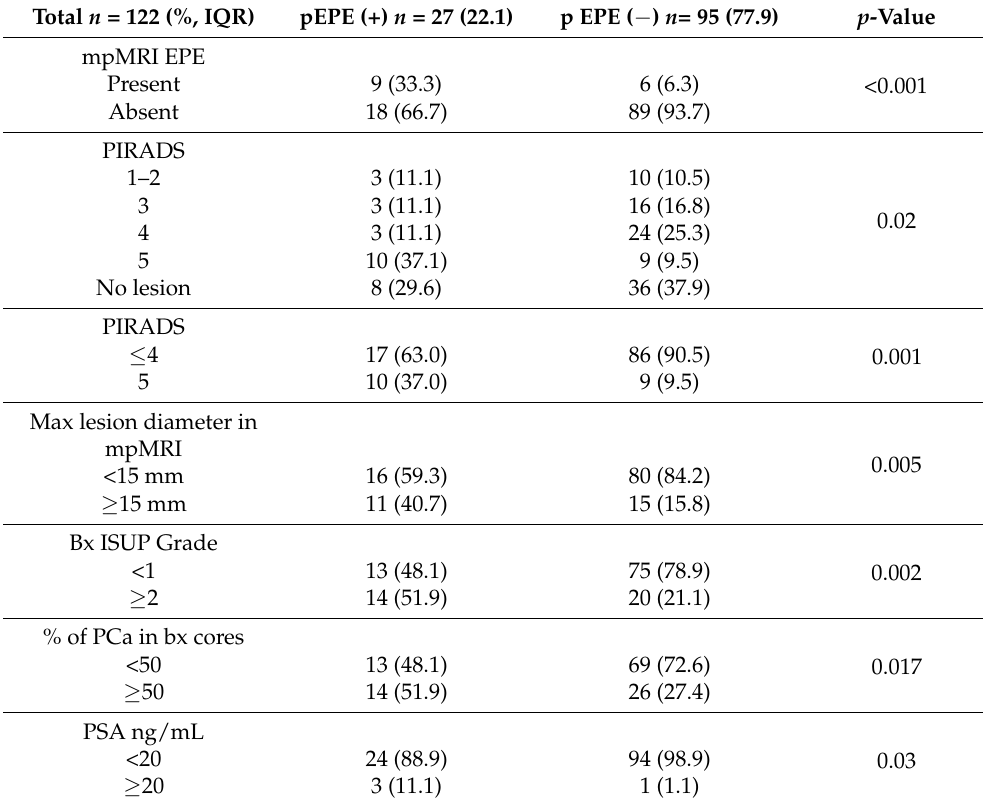
Table 2. Analysis of EPE factors for each side of the